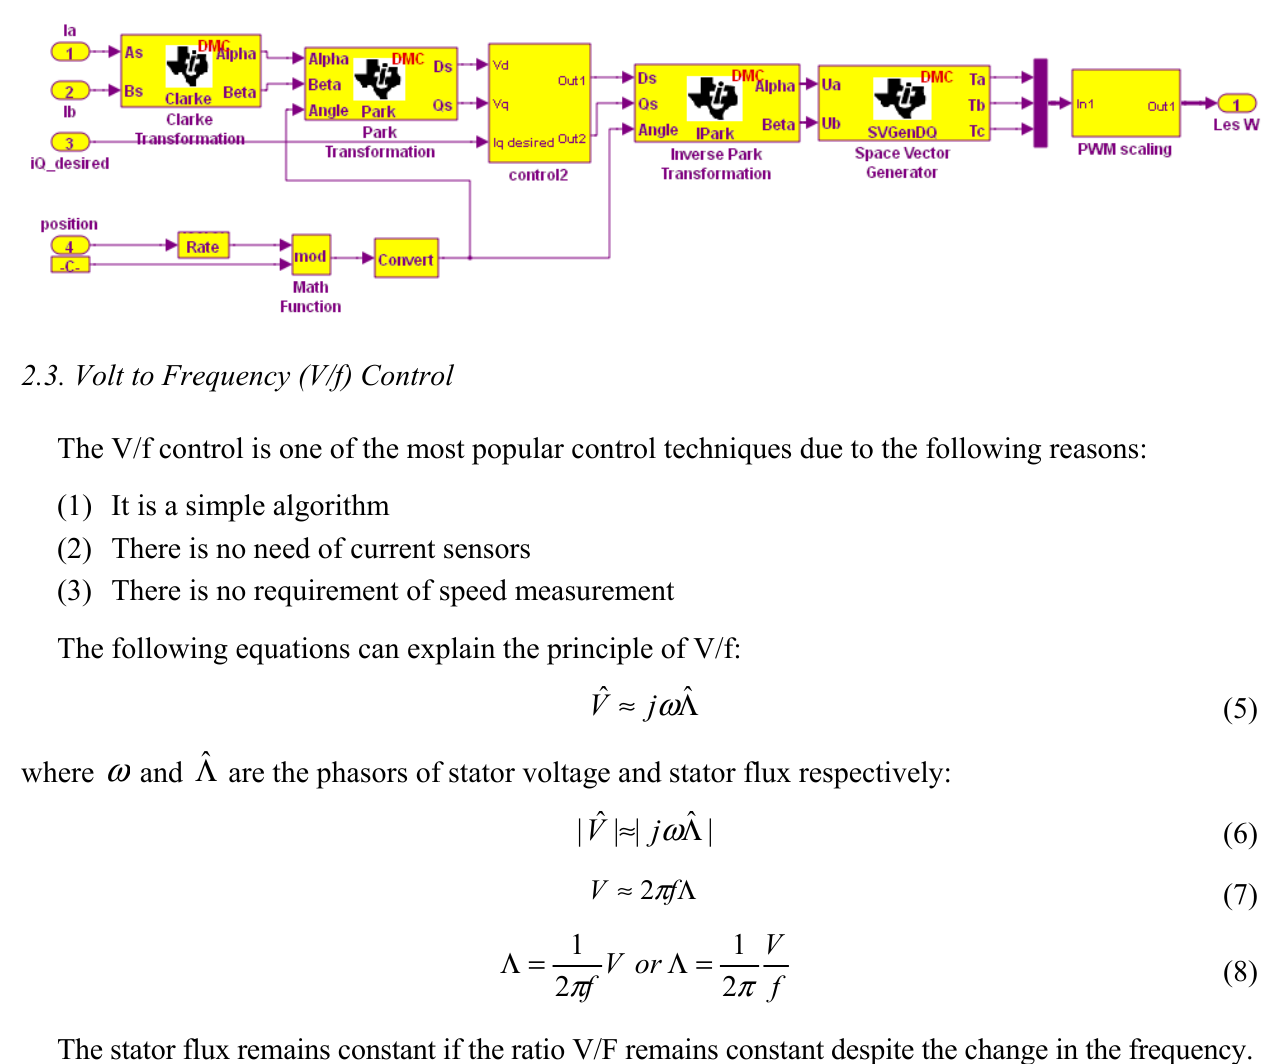
Figure 4. Simulink implementation of sensorless vector